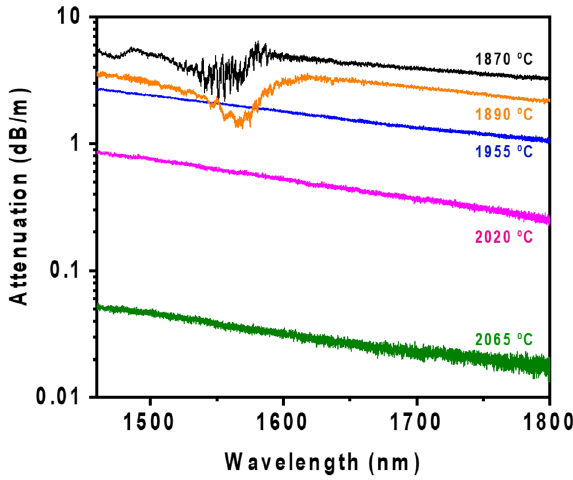
Figure 5. Fiber attenuation vs wavelength (nm) for the enhanced scattering fibers drawn from preform D at temperatures in the range 1870–2065 °C. Fibers drawn at temperatures above 2065 °C are not considered since no backscattering enhancement was registered. Linear fits for the range 1620–1800 nm and 1500–1800 nm, are included in the plot for fibers drawn at 1870–1890 °C and 1955–2065 °C,